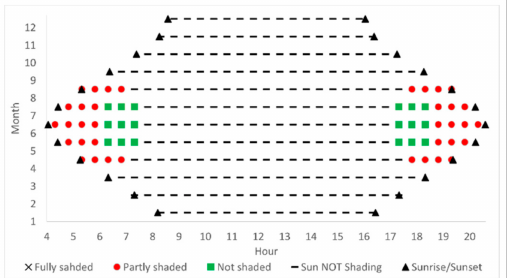
Figure 11. State of shading: south-facing surface, latitude 52.2 ◦ N, D = 20 m, H = 10 m, L = 40